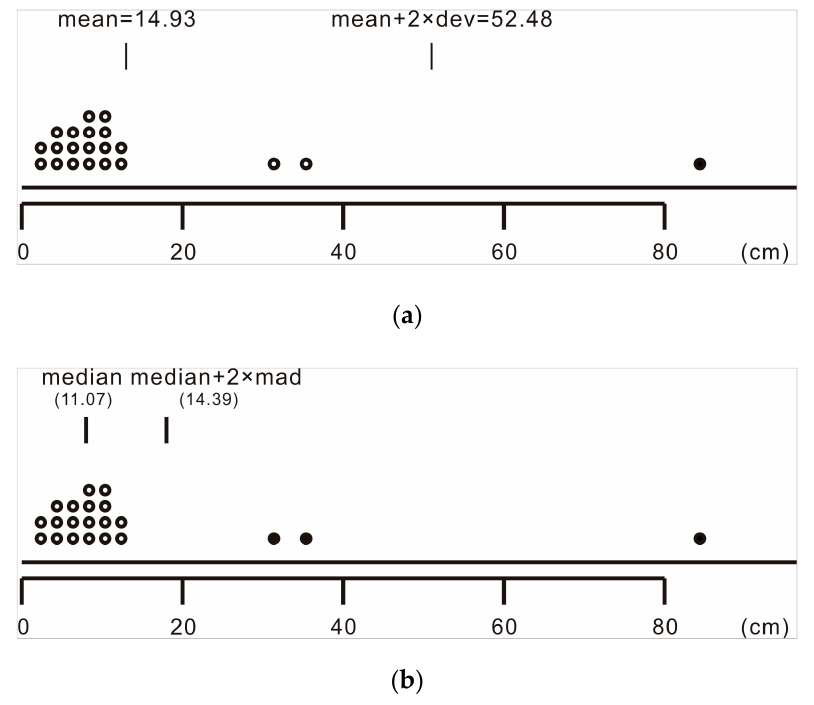
Figure 9. ( a ) Rejection result via the standard-deviations-from-mean approach; ( b ) rejection result via the MAD-from-median method.